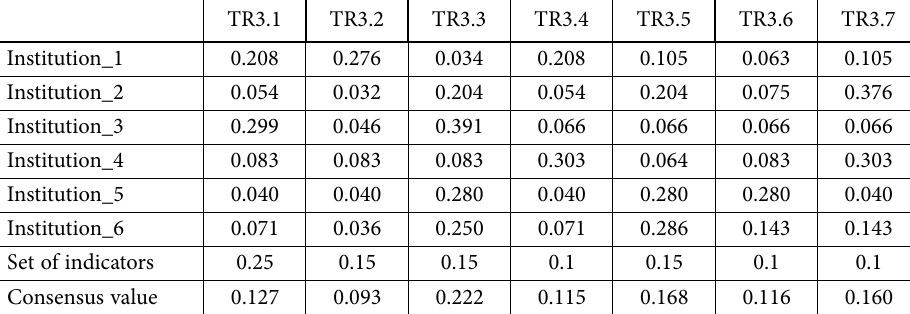
Table 5. Transparency-indicator weighting. Social support block